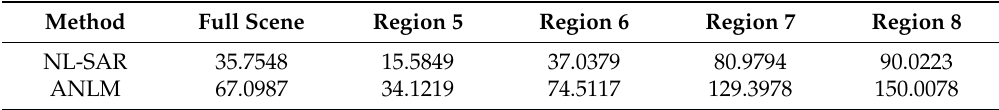
Figure 14. Enlarged ENL NLRB map on marked region 5. ( a ) NL-SAR filter. ( b ) ANLM filter. ( c ) The ENL NLRB difference between ANLM and NL-SAR filters. Table 4. Quantitative comparison of NL-SAR and ANLM filters by average ENL NLRB on full scene and marked regions 5–8 in Figure 10a.